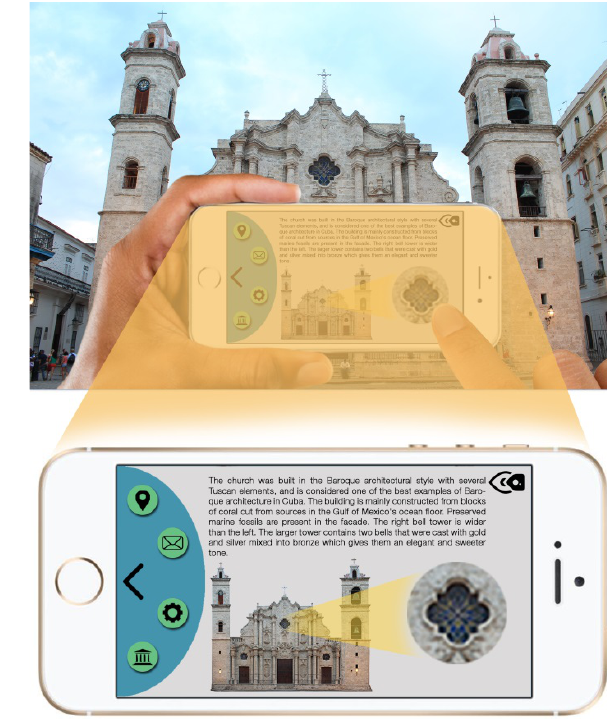
Figure 11. Example of an application of aumented reality (Casa de Baños - Plaza de la Catedral)